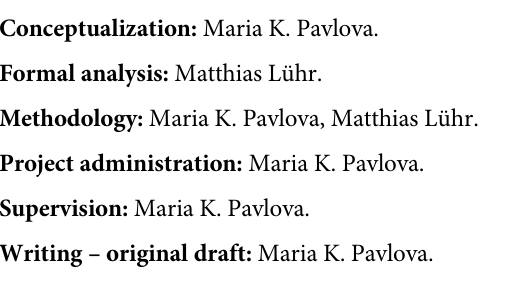
S1 Fig. Country distributions of estimated main effects of voluntary participation on all eudaimonic and social well-being outcomes (Study 2). S2 Fig. Scatterplots of the main effects of voluntary participation all eudaimonic and social well-being outcomes against each country-level indicator (Study 2). S3 Fig. Country distributions of the interactions between voluntary participation and age in relation to eudaimonic and social well-being outcomes (Study 3). S4 Fig. Scatterplots of the interactions between voluntary participation and age against all country-level indicators foreseen by the hypotheses (Study 3). S5 Fig. Scatterplots of the interactions between voluntary participation and age against GDP per capita (Study 3, post-hoc